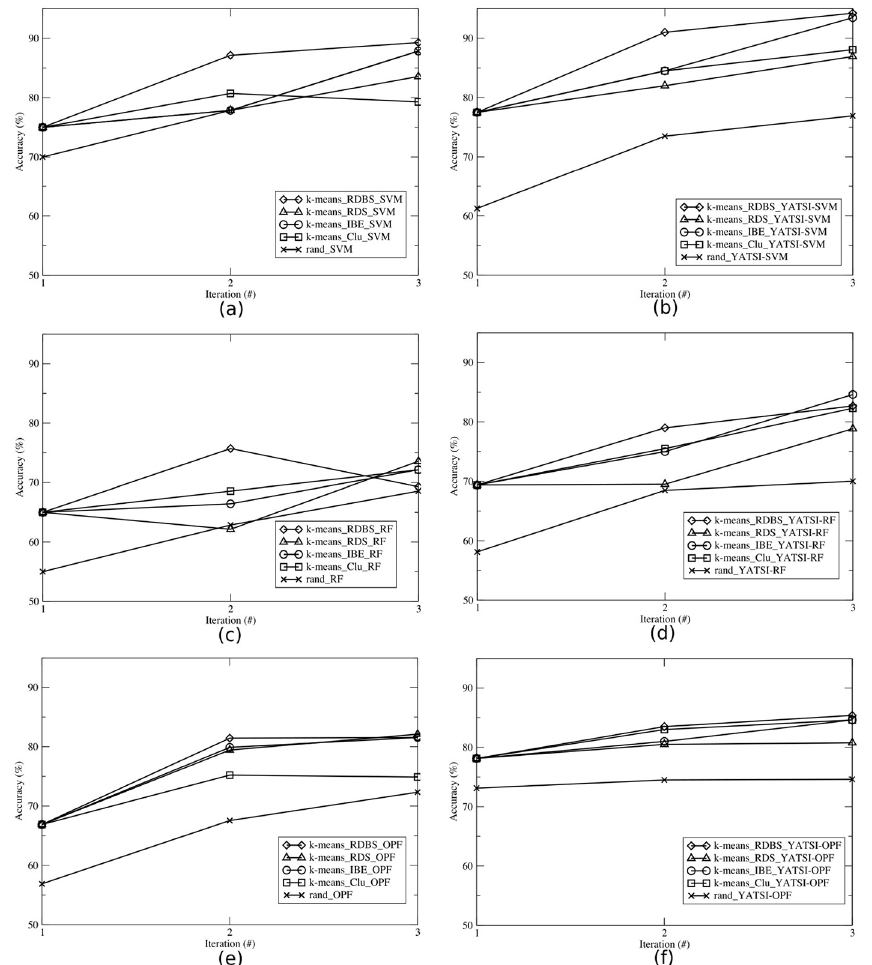
Fig 5. Average accuracies per iteration obtained by each selection strategy (RDBS, RDS, IBE, Clu, and rand), using the ALL-AML dataset and the classifiers: (a) SVM, (b) YATSI-SVM, (c) RF, (d) YATSI-RF, (e) OPF, and (f)